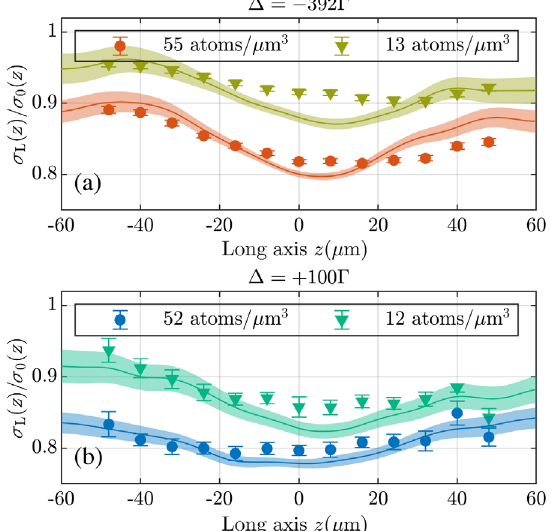
interaction.FIG. 4. (a) Relative average transverse width after illuminating the BEC for 5 μ s (with beam intensity I ¼ 11 . 54 mW = cm 2 or s ¼ 150 × 10 − 6 at Δ ¼ − 100 Γ ) as a function of the detuning Δ after 100 ( ^ ¼ 54 atoms = μ m 3 , turquoise circles) and 200 μ s ( ^ ¼ 16 atoms = μ m 3 , purple triangles) free expansion time. We observe a reduction of the transverse width for red and blue detunings, while the maximum compression is redshifted from the bare atomic resonance at Δ ¼ 0 . (b) Atomic signal after illumination normalized to the initial signal for a mean atomic density of 54 atoms = μ m 3 . Close to resonance, we observe not only a growing scattering halo around the 1D BEC (turquoise circles), but also the onset of superradiance and additional atom loss (reduction of the total signal, black triangles). We also observe a redshift in the losses. These phenomena are not included in the numerical simulations [solid lines in (a)], which, therefore, only qualitatively match the data. The error bars depict the standard error of the mean. Because of the strong loss close to resonance, the data are postselected based on the remaining atom number in the 1D BEC (cf. Fig. 9). The dashed line in (b) shows the signal remaining in the 1D BEC after illumination of a dilute cloud ( 500 μ s expansion time). For dilute clouds, the total signal remains